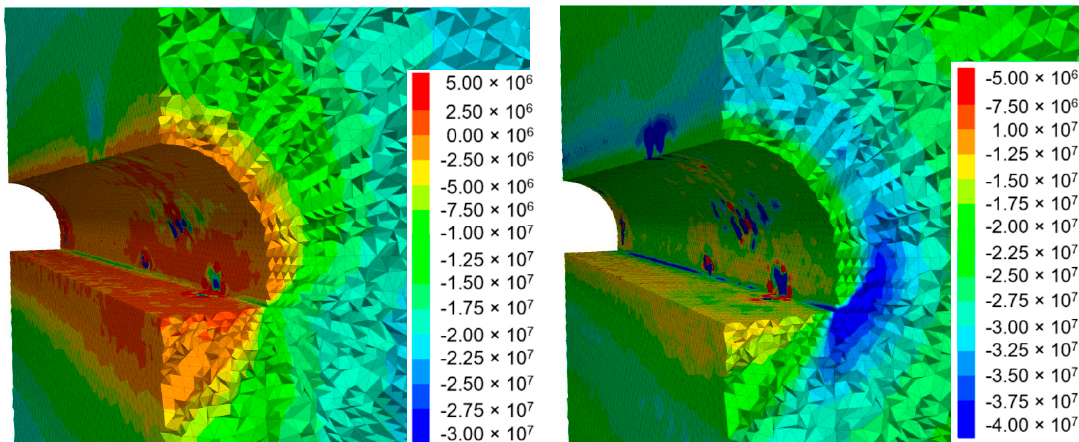
Figure 12. Distribution of the largest and smallest main stresses expressed in pascals for the model with dispersion of strength and deformation parameters with a variability coefficient of 25%.